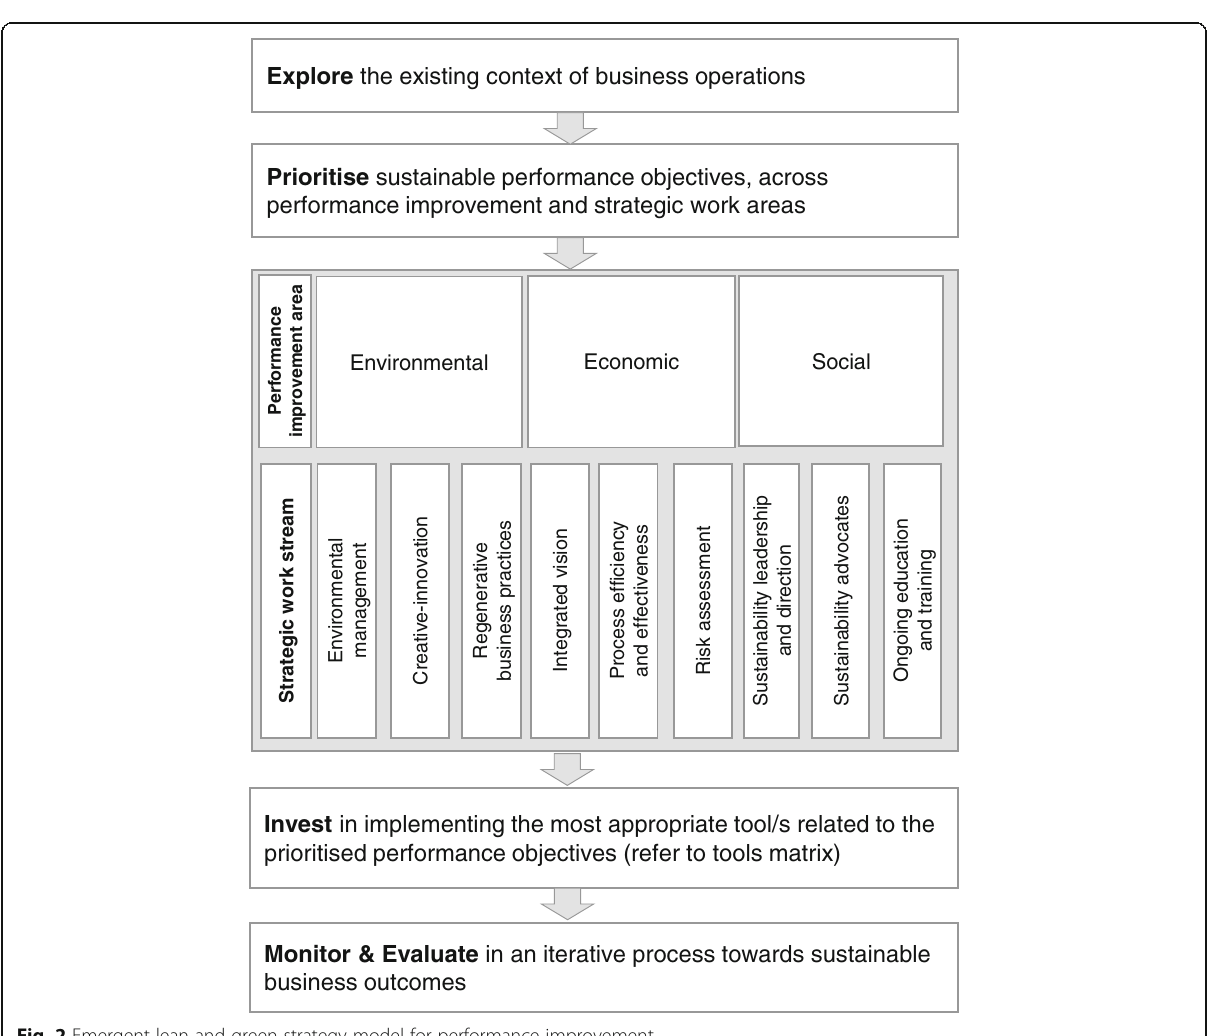
Fig. 2 Emergent lean and green strategy model for performance